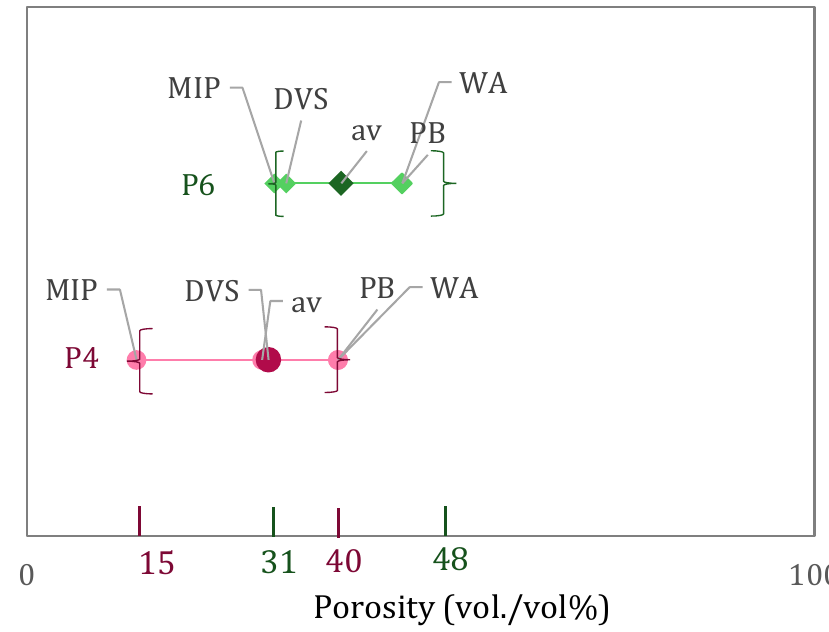
Figure 5. Porosity values obtained from MIP, DVS, WA and PB of pastes P4 and P6.